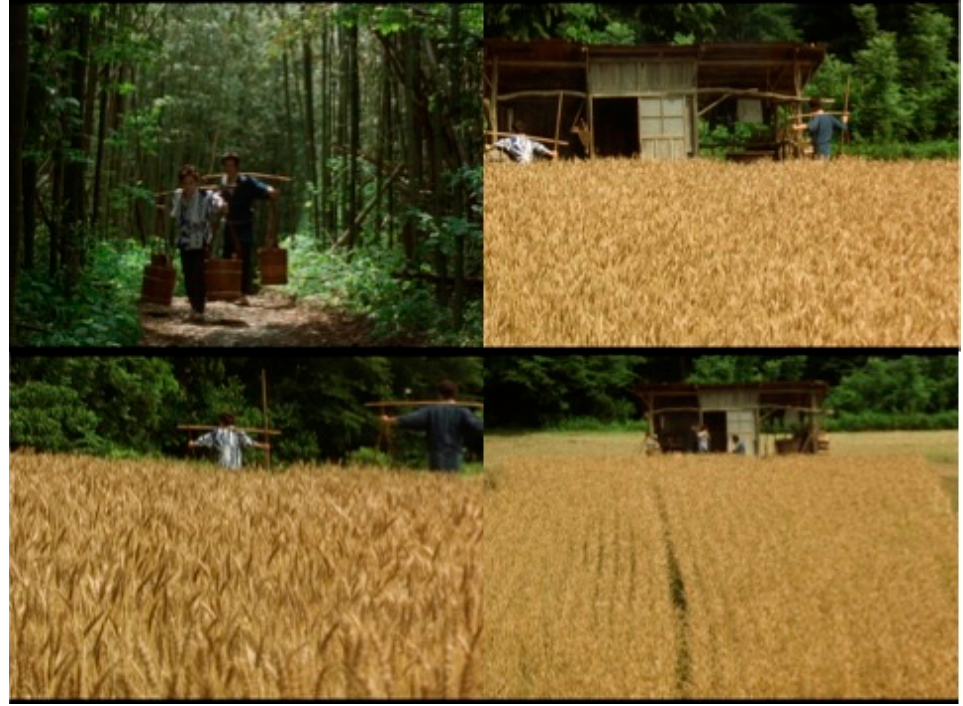
Figure 4. A Postcard (Shind ō Kaneto, 2011).